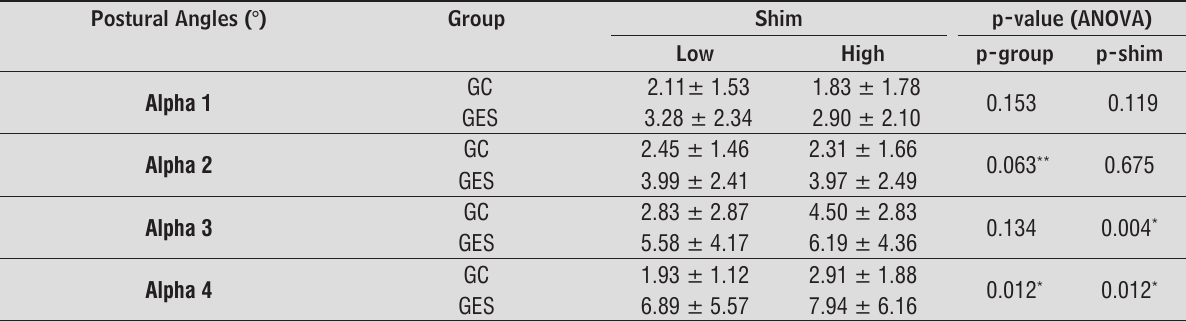
Table 2 - Analyses of postural angles with respect to the group and shim factors between the control and experimental "S" groups in the static condition with right shim